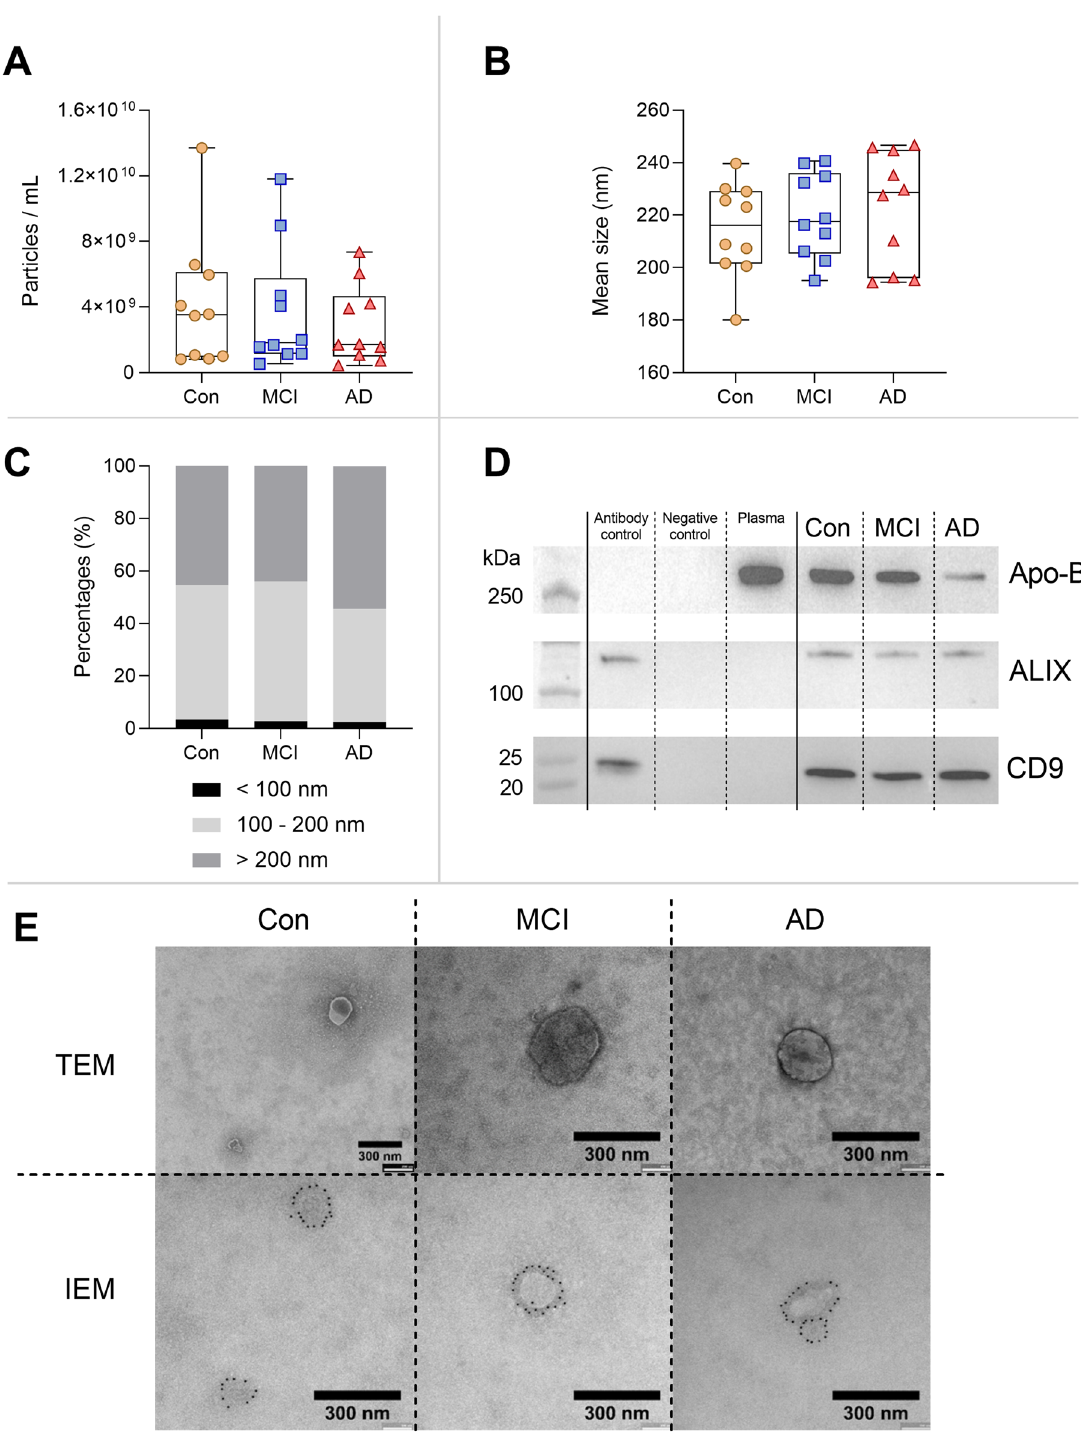
Figure 1. Characterisation of extracellular vesicles. NTA measurements show the particle concentrations ( A ) and mean particle sizes ( B ) for all three groups. ( C ) Size distribution of measured particles presented with similar profiles, with most particles in the size range of 100 – 200 nm. Boxplots depict median with interquartile ranges. ( D ) Western blotting of pooled EV pellets for all groups, confirming the presence of EV markers CD9 and ALIX, and the lipoprotein marker Apo-B. ( E ) TEM images of negative stains of pooled EV pellets from the three groups. IEM images present with CD9 + vesicular structures, with immunoreactivity confined to the outer membrane of the structures. The scale bars are 300